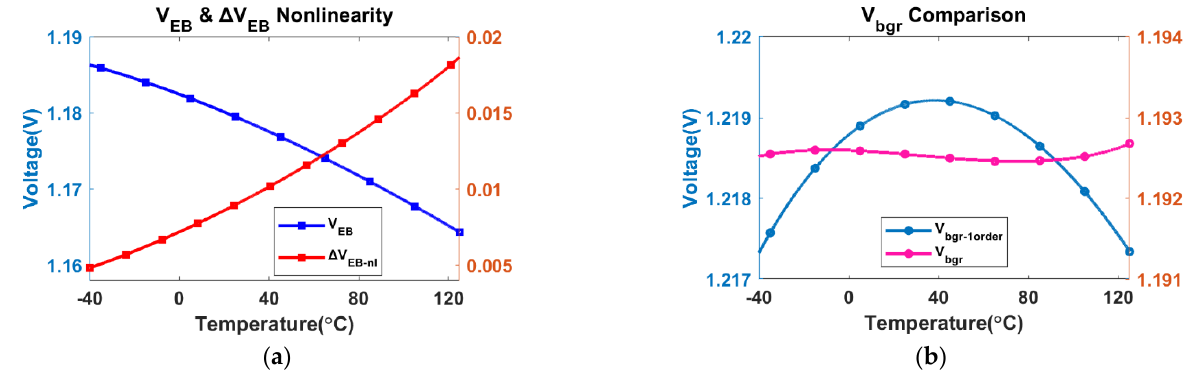
Figure 8. Simulated results of ( a ) V EB and Δ V EB versus temperature; ( b ) the first-order and proposed compensation of V bgr versus temperature.